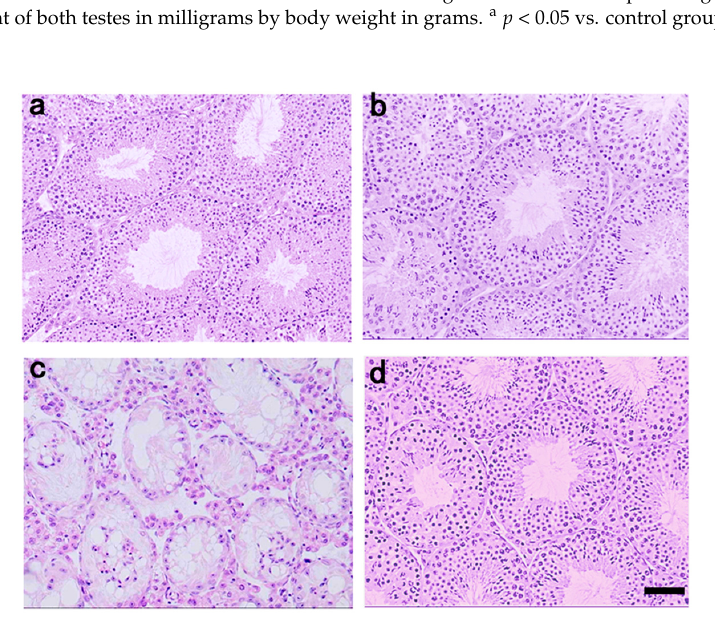
Figure 2. Histological examination of the testes ( n = 10) at day 120 in each group. Intact seminiferous tubules showing all maturation stages of the germinal epithelium from spermatogonia to spermatozoa are seen in the control group ( a ) and the control+TJ107 group ( b ). Atrophic seminiferous tubules with azoospermia are seen in the BSF group ( c ). Normal-appearing seminiferous tubules are seen in the BSF+TJ107 group ( d ). Bar = 50 µm.